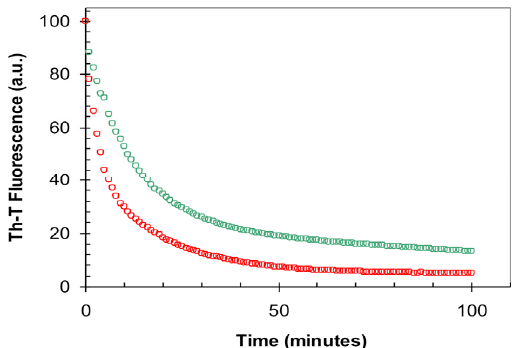
Figure 7. Depolymerization of URN1-FF fibrils in the presence of 15% TFE. Change in ThT fluorescence (25 μ M) after 5-fold dilution of URN1-FF f0% (red) and f15% (green) fibrils in 15% TFE, shown in arbitrary units